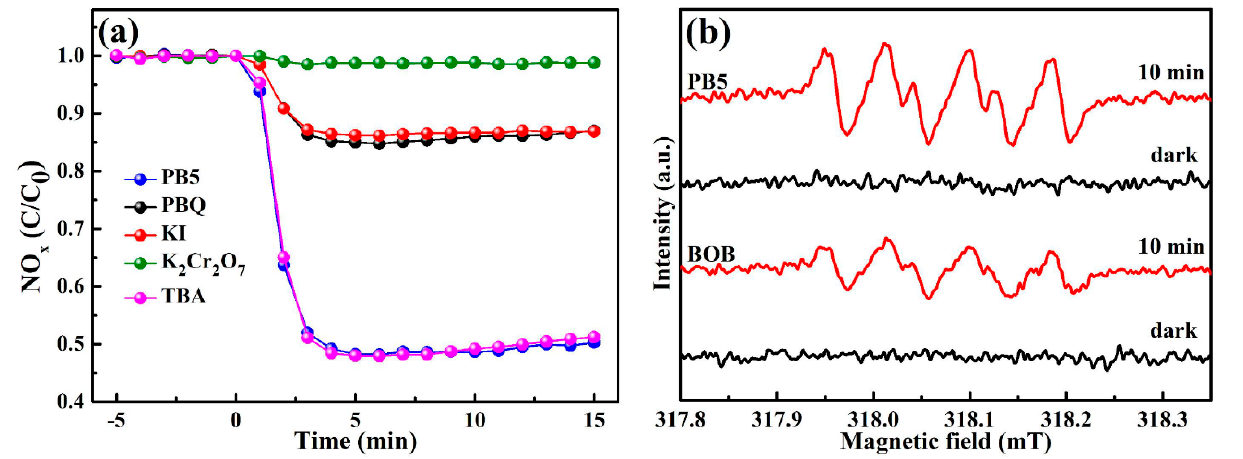
Figure 5. Photocatalytic NO x removal in the presence of PB5 by charging different trapping reagents ( a ); ESR spectra of DMPO-·O 2 − adducts of BOB and PB5 in dark and under visible light ( b ). In order to discover the photocatalysis mechanism, the band structures were deter- mined by the flat band potentials ( E fb ), which were measured by the electrochemical method. From the Mott–Schottky curves, the slopes of both BOB in Figure 6a and BPO in Figure 6b are positive; thus, both samples are n-type semiconductors. The intersection points of the slopes with the X axis are − 0.68 V for BOB and − 0.31 V for BPO versus the saturated calomel electrode (SCE), which correspond to − 0.44 and − 0.07 V versus the nor- mal hydrogen electrode (NHE) [47], respectively. Moreover, for an n-type semiconductor, the gap between E fb and E CB is around 0.1–0.3 eV [48], and 0.2 eV was selected in this study. Accordingly, the values of E CB of BOB and BPO are − 0.64 and − 0.27 V, respectively. The E VB potentials of BOB and BPO were calculated as 1.63 and 3.32 V, thanks to the formula E CB = E VB − E g .